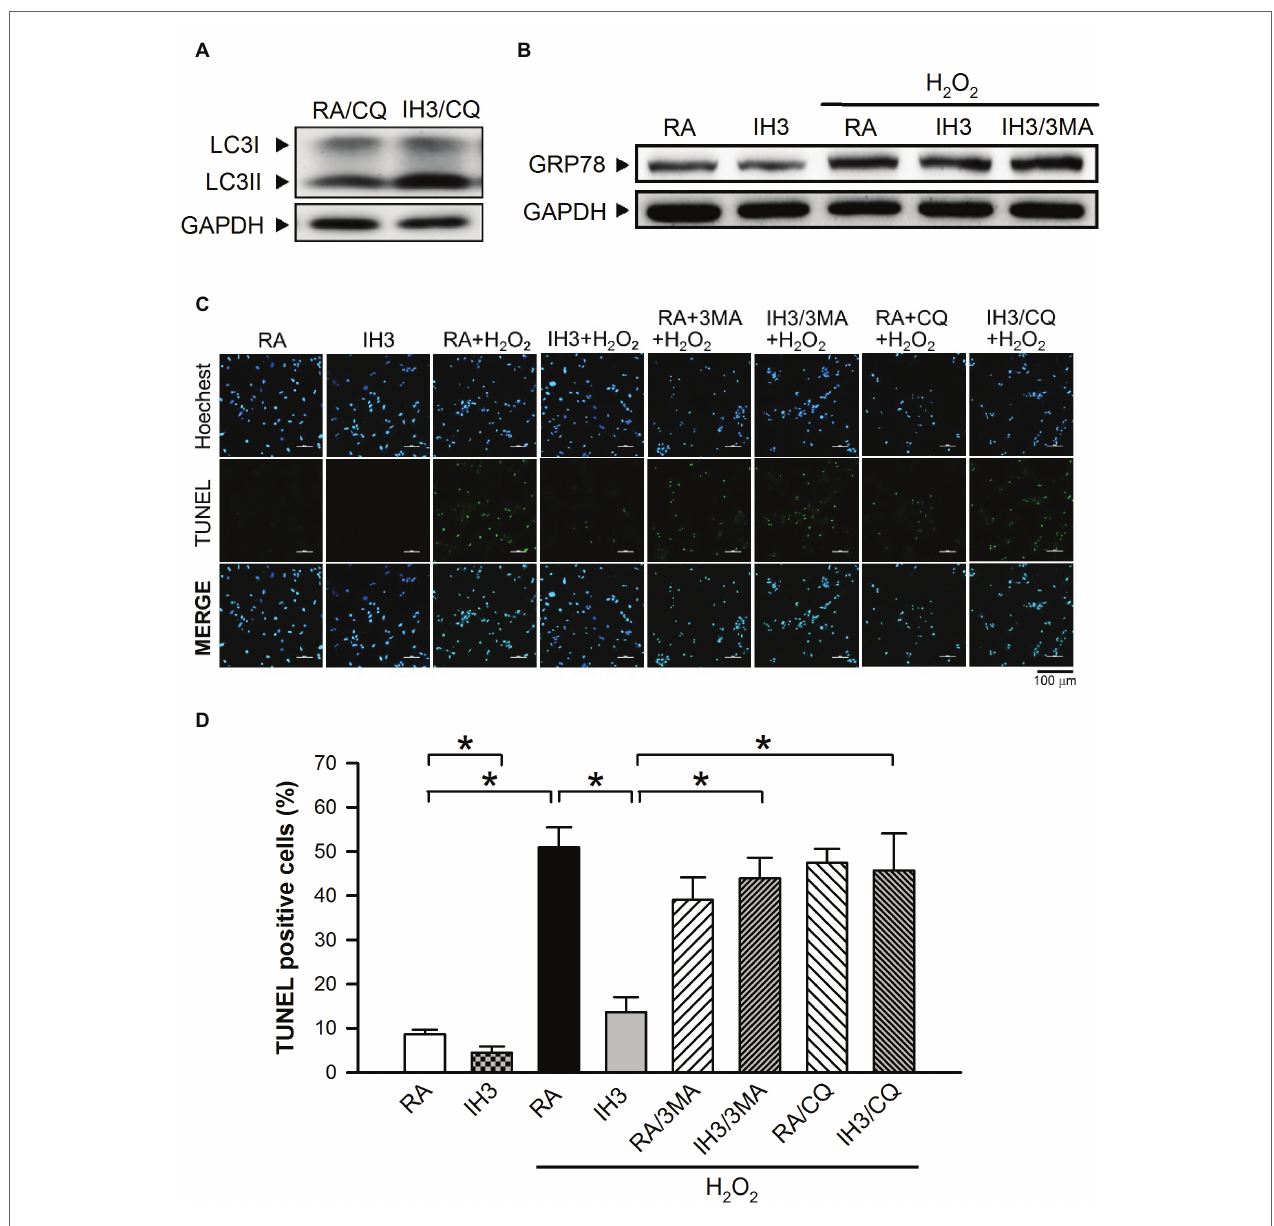
FIGURE 7 | Involvement of autophagy in the IH-attenuated ER stress-induced cell death in cultured rat primary cardiomyocytes. (A) Cardiomyocytes were treated with RA or IH for 3 days followed by chloroquine (5 μM) for additional 24 h, and then harvested for LC3 protein level determination. A representative result of LC3 and GAPDH protein levels determined by Western blot analyses was shown. (B) Cardiomyocytes were treated with RA or IH for 3 days followed by H 2 O 2 , H 2 O 2 combined with 3-methyladenine (50 μM) for additional 24 h, and then harvested for GRP78 protein levels determination. A representative result of GRP78 and GAPDH protein levels determined by Western blot analyses. (C) Cardiomyocytes were treated with RA or IH for 3 days followed by H 2 O 2 , H 2 O 2 combined with 3-methyladenine (50 μM), H 2 O 2 combined with chloroquine (5 μM), or H 2 O 2 combined with wortmannin (5 nM) for additional 24 h, and then harvested for apoptotic cell detection. Cardiomyocytes were analyzed by confocal microscopy using TUNEL stain. Apoptotic cells were identified as TUNEL-positive ( green ). Nuclei were identified as Hoeshe-positive ( blue ). (D) Quantitative results of TUNEL-positive cells were expressed as ratio over the RA control group. Values are means ± SEMs. ( n = 7). * p < 0.05. 3MA, 3-methyladenine; CQ, chloroquine; IH, intermittent hypoxia; RA, room air; Wort,